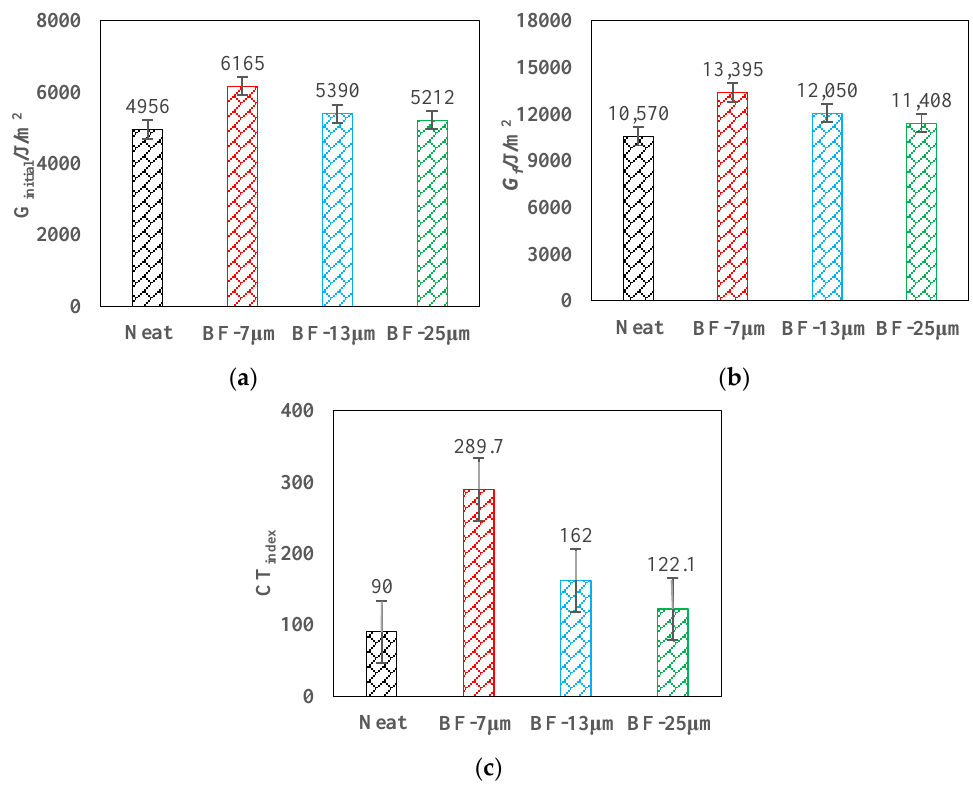
Figure 12. IDEAL cracking test results: ( a ) initiation energy; ( b ) fracture energy; ( c ) cracking test indexes.